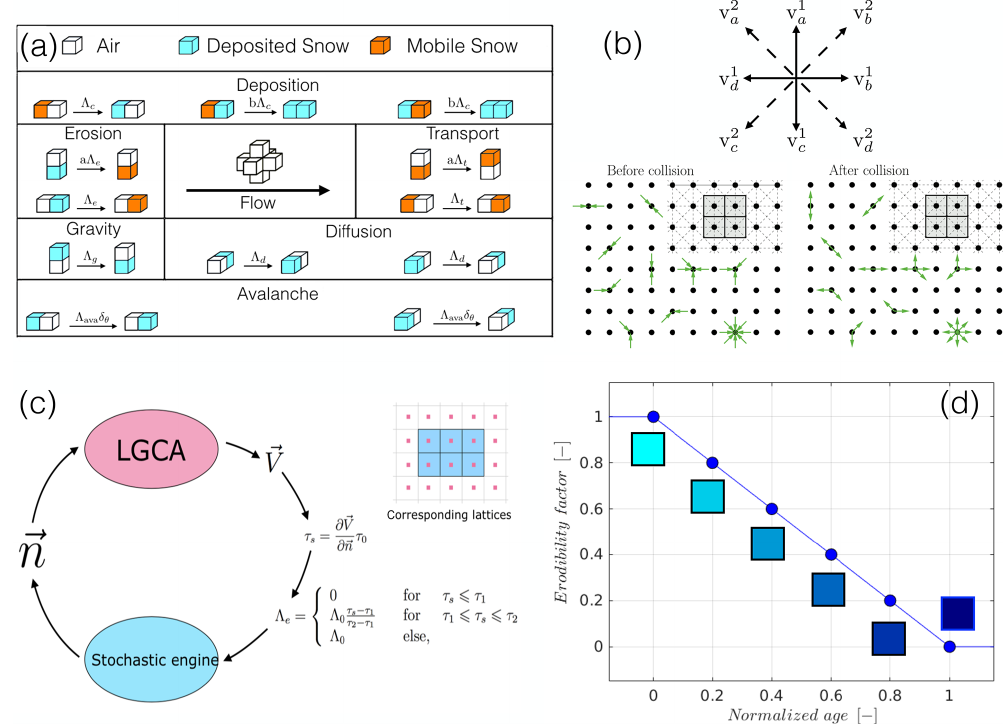
Figure 1. Description of the modelling framework. (a) Transition rules for CA of snow transport. (b) LGCA approach for simulating air flow. (c) Schematic of the coupling between the CA and the LGCA models. (d) A simple sintering mechanism that reduces snow mobilization as a function of its age. Note that (a) and (b) are adapted from Narteau et al.